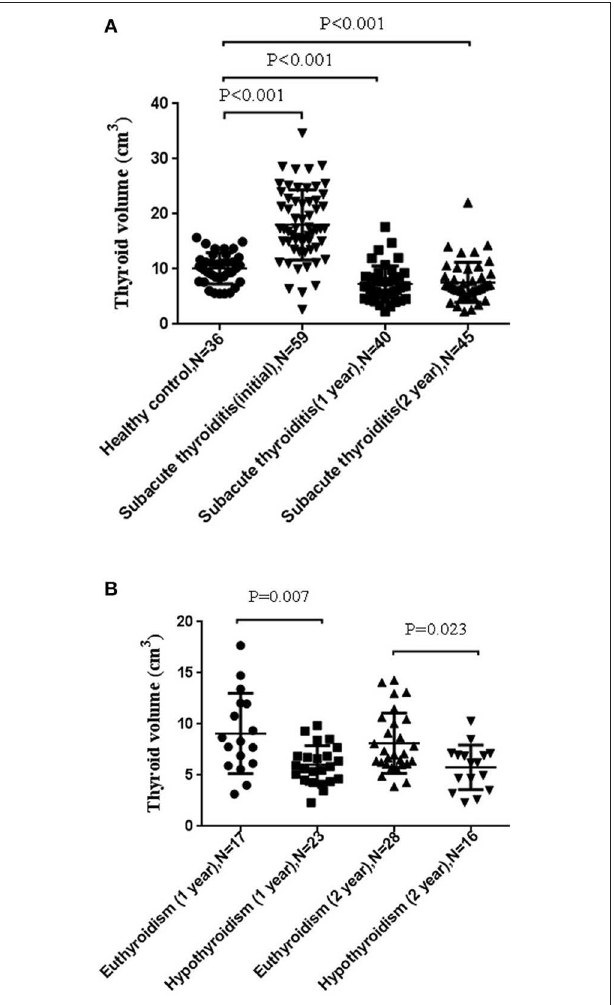
FIGURE 2 | The thyroid volume of subacute thyroiditis (SAT) at 1 and 2 years was significantly smaller. (A) Comparison of the thyroid gland volumes between SAT patients at initial, 1 and 2 years of follow-up and those of healthy controls. (B) Comparison of thyroid volumes of SAT patients after 1 year and 2 years of hypothyroidism with those of euthyroid